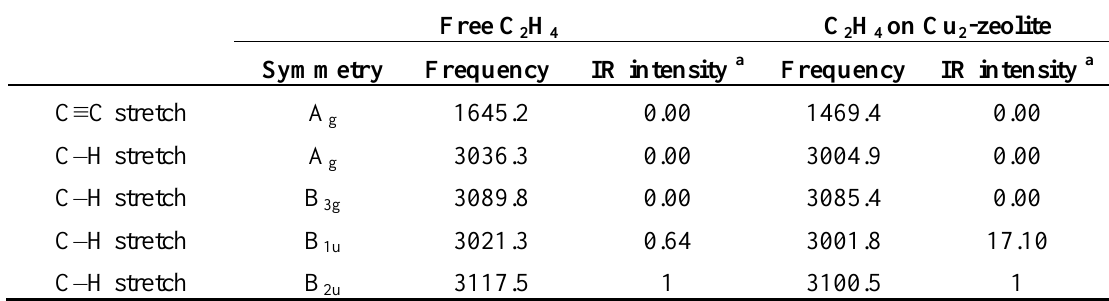
Table 7. Calculated vibrational frequencies (cm -1 ) of CC and CH stretching modes of C before and after the binding into the small dicopper zeolite